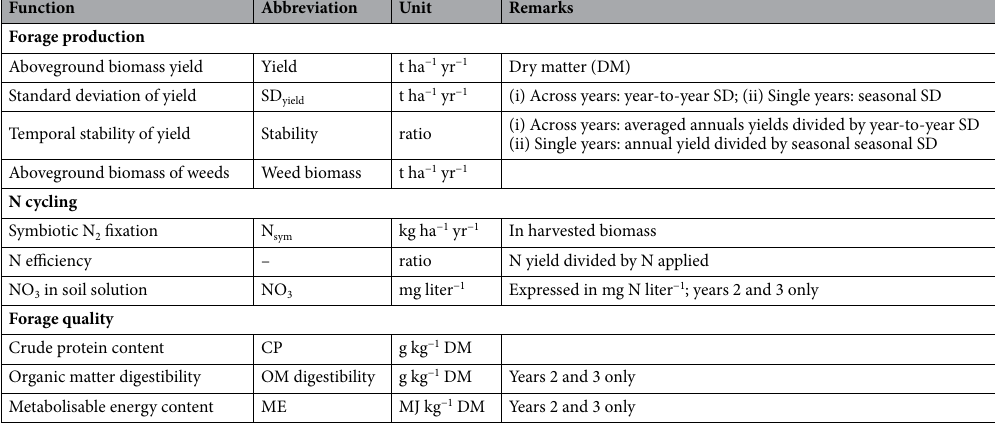
Table 1. Overview of functions measured in the